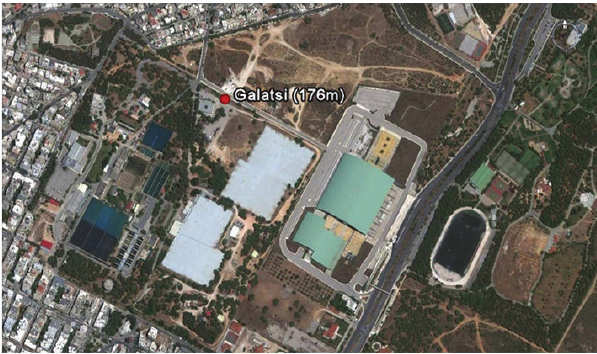
Figure 2: Map of the examined monitoring site of Galatsi with its altitude above sea level (from Google Maps-Google